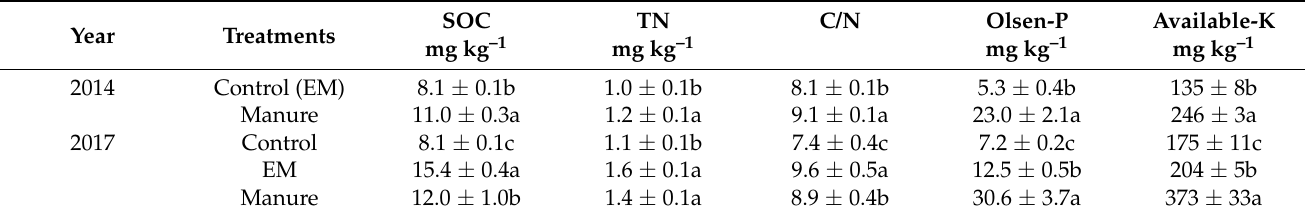
Table 1. Changes in soil organic carbon (SOC), total nitrogen (TN), the carbon/nitrogen ratio (C/N) and other chemical parameters in the period from before wheat sowing in 2014 to after wheat har- vest in 2017. Year